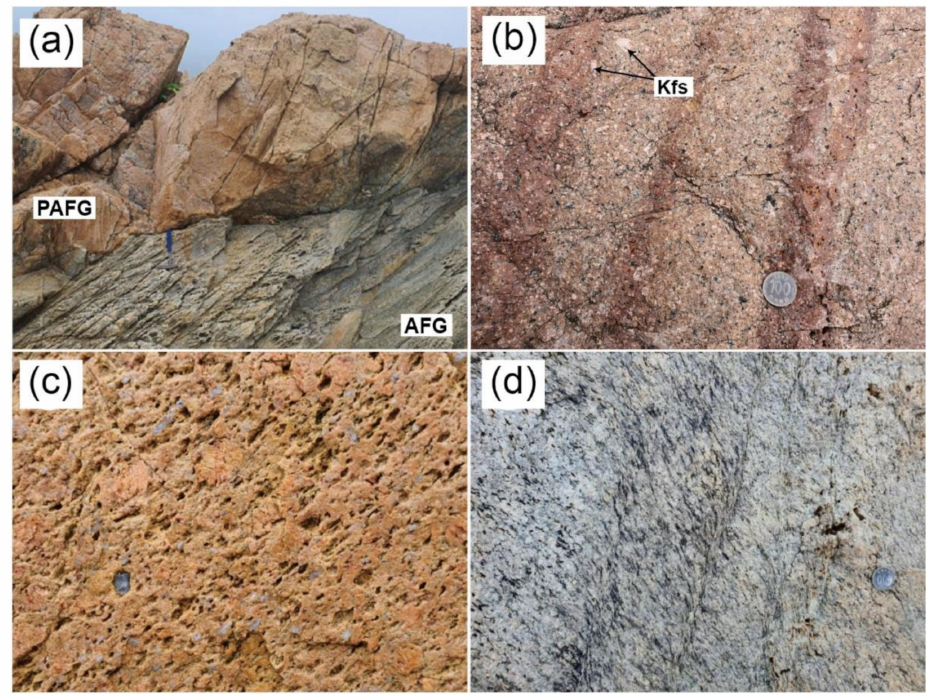
Figure 4. Outcrop photographs of the PAFG. ( a ) Intrusive contact relationship between the PAFG and AFG. ( b ) Porphyritic texture developed in the PAFG. ( c , d ) Minor continuous shear zones with a dextral sense of shear. Abbreviations: